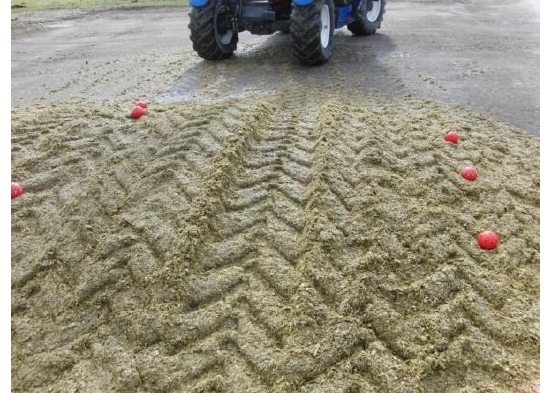
Figure 4. The sensor network within the prepared storage